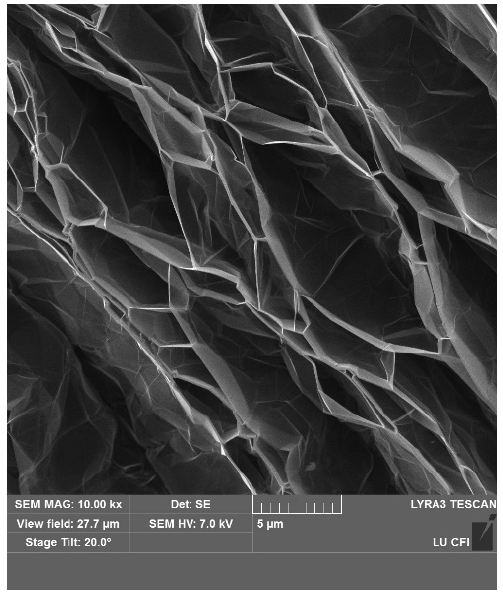
Figure 1. SEM inspection of graphene sheet stacks.